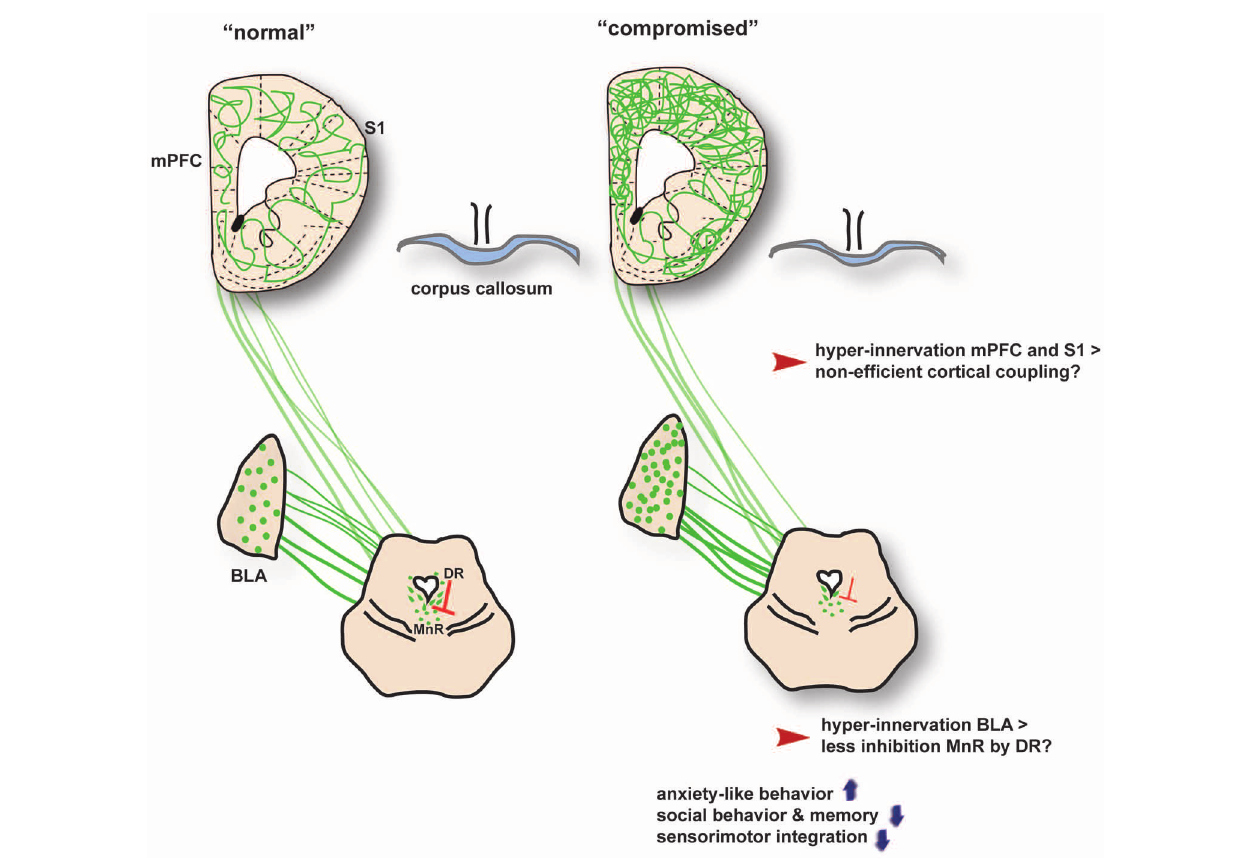
median raphe nucleus; S1, somatosensory cortex; mPFC, medial prefrontal cortex. The interaction between the DR and MnR is based on findings in 5-HTT knockout rats by Witteveen et al.,